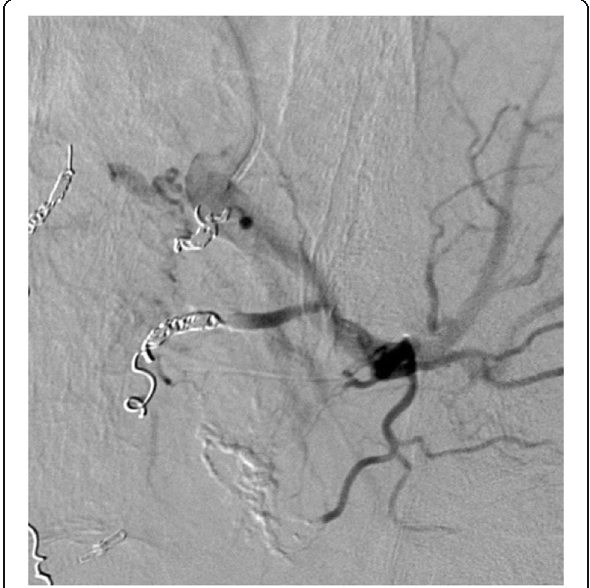
Fig. 6 Fistula embolization was performed for the branches of the median sacral artery and bilateral internal iliac artery with micro coil, gelatin sponge, and n-butyl-2-cyanoacrylate